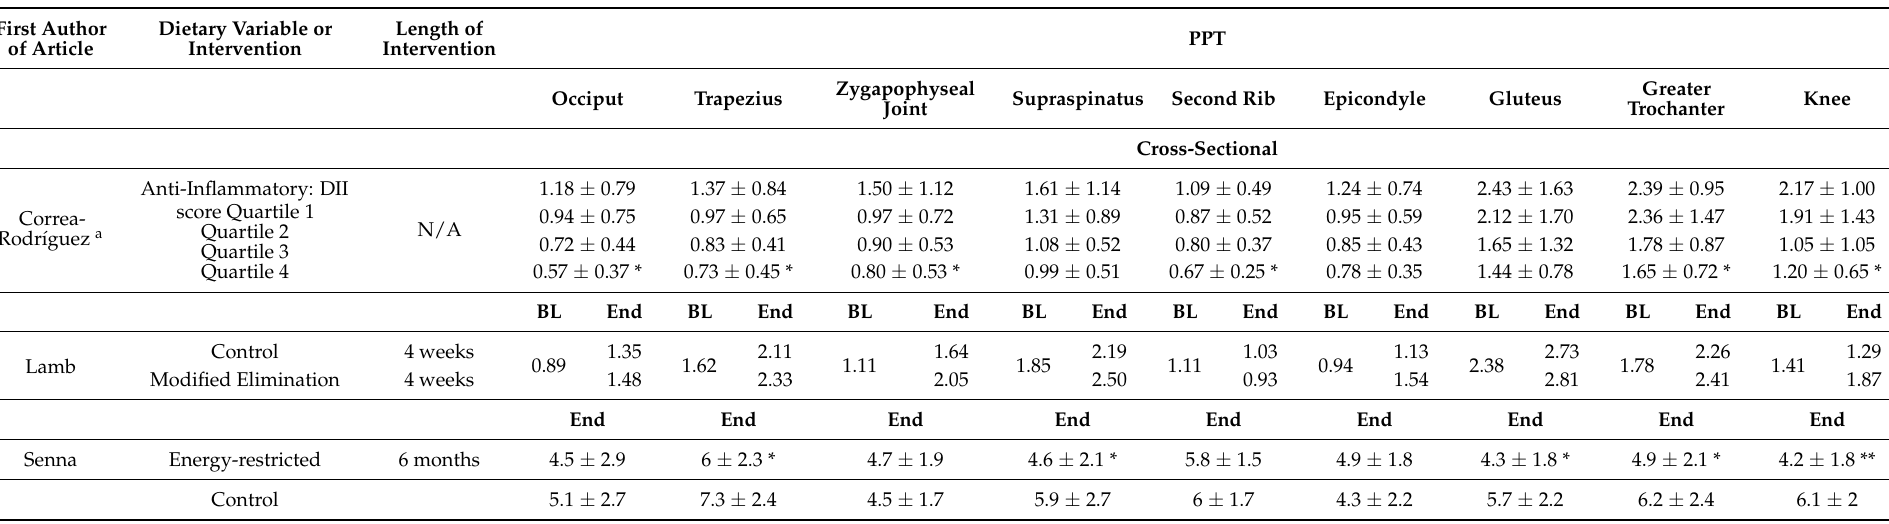
Table 4. Effects of diets on pain symptoms measured by Pain Pressure Threshold